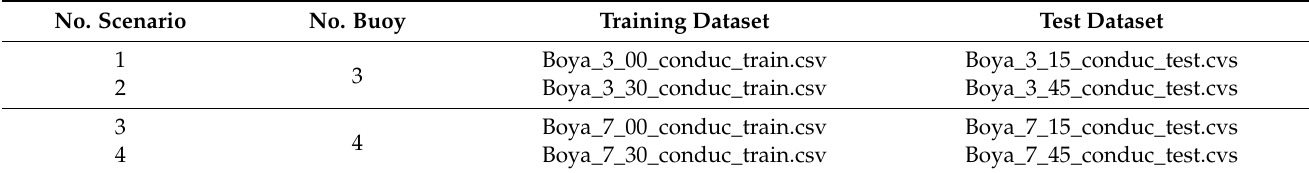
Table 5. Details of the experimentation